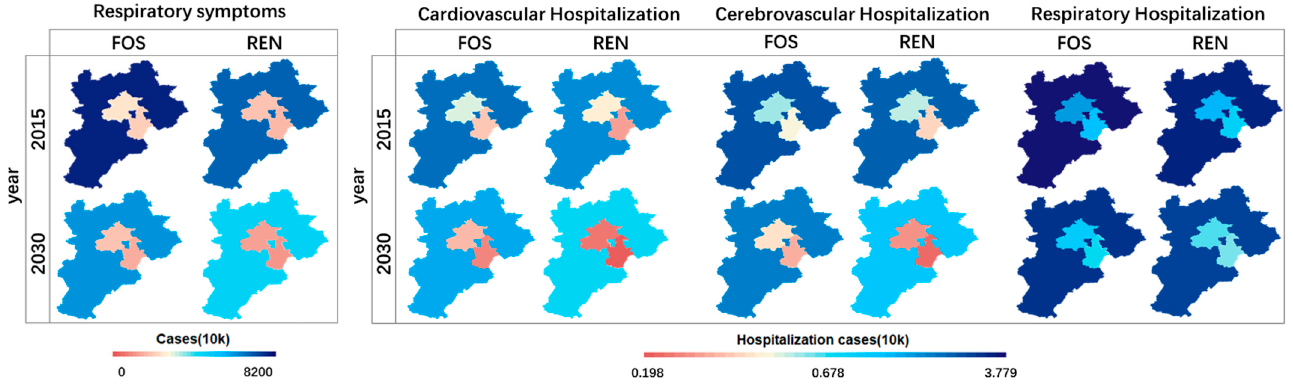
Figure 4. Morbidity in different scenarios.